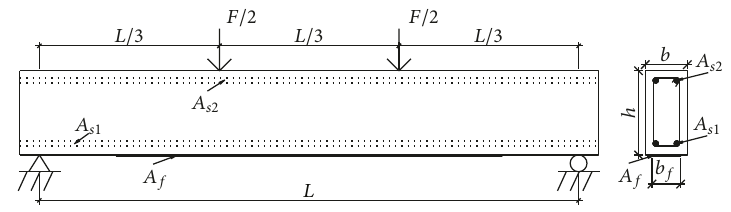
Figure 8: Loading scheme of tested beams. Table 1: Properties of specimens and materials.